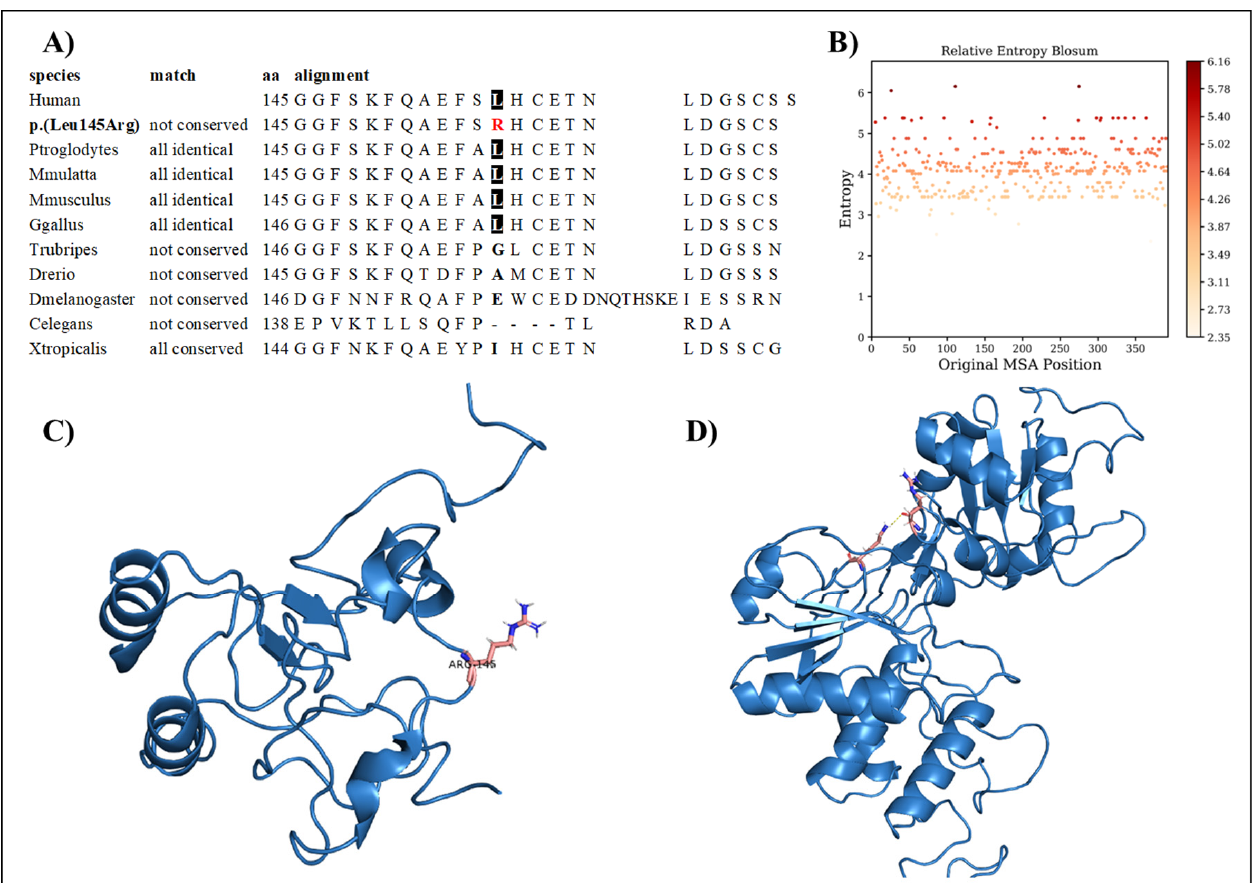
Figure 2. ( A ) Amino acid conservation across species of the DUSP6 variant, showing that Leu145 is moderately conserved. ( B ) Relative entropy plots. ( C ) Mutant DUSP6 with Leu145Arg highlighted in pink. ( D ) The DUSP6 AlphaFold model.